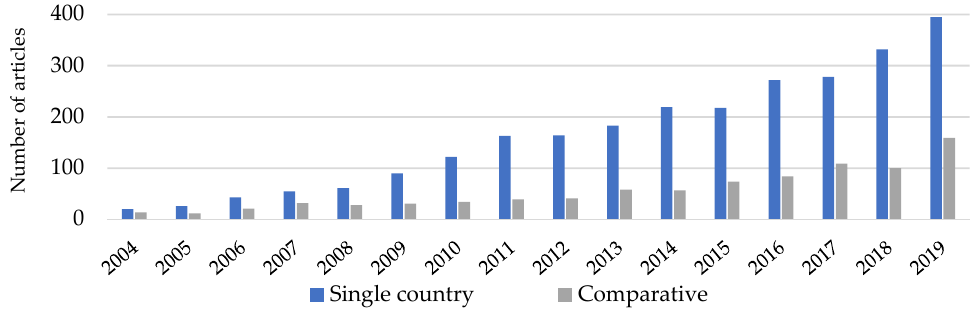
Figure 6. Share of single country and comparative studies. Source: Authors; N = 3534.